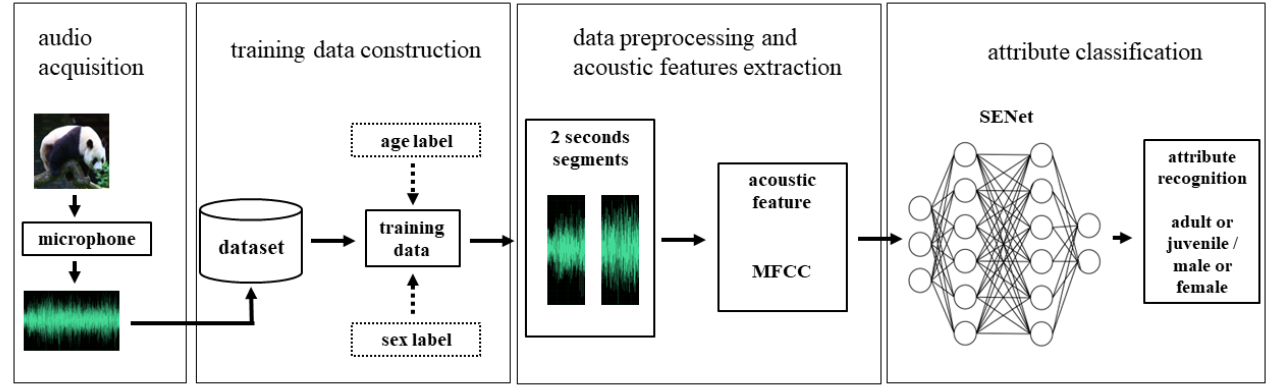
Figure 2. An illustration of the methods used in this study, from audio acquisition to final attribute classification. Note that age group classification and sex classification were done separately, and both were approached as binary classification tasks.